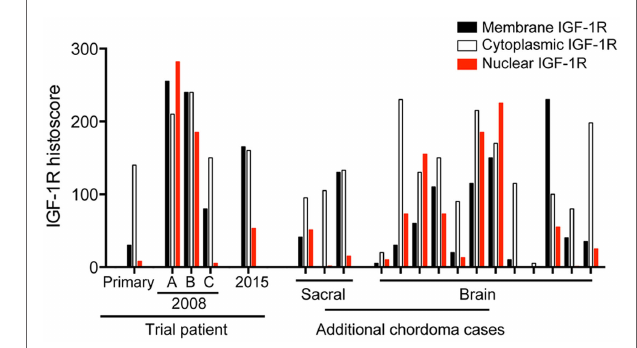
FIGURe 4 | Brain and spinal chordomas contain IGF-1R with variable membrane, cytoplasmic, and nuclear positivity . IGF-1R IHC was performed on the primary tumor, 3 tumor blocks from the 2008 recurrence and one block from the 2015 (post-trial) recurrence of the trial patient, and 15 additional chordoma cases. Each tumor was scored for IGF-1R signal in the membrane, cytoplasm, and nucleus for the percentage showing zero (0), weak (1), moderate (2), or heavy (3) IGF-1R intensity, giving a maximum histoscore in each subcellular location of 100% × 3 =